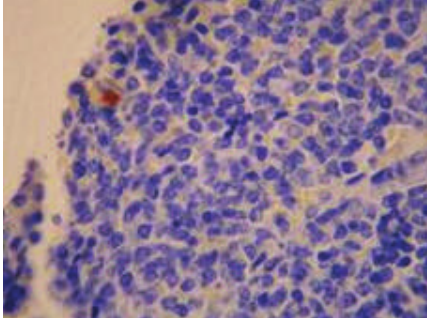
Figure 2: Treated group—6 hours in SAP experiment spleen (several apoptoic cells) TUNEL, × 400.